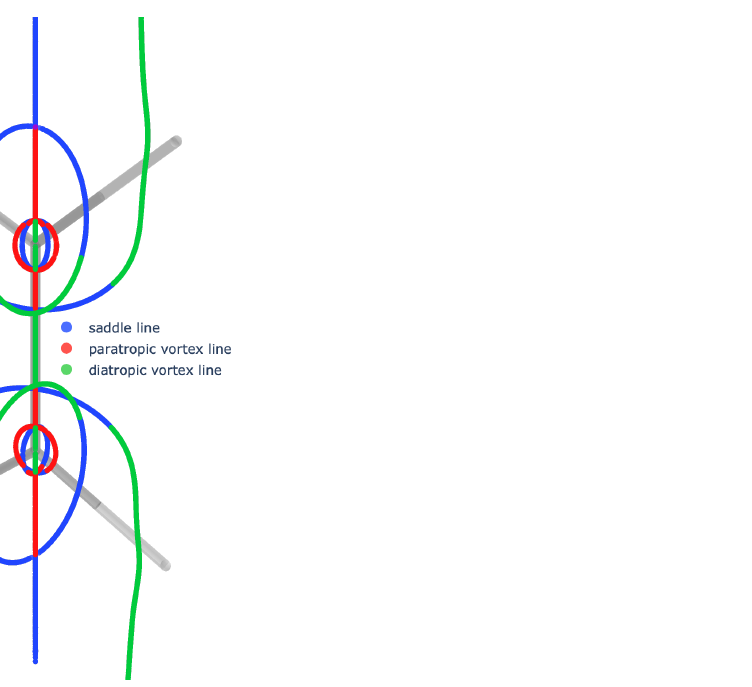
Figure 7. The stagnation graph of the C 2 H 4 molecule in its equilibrium geometry with a magnetic field of 0.05 B 0 along the z -axis. The interactive version of this figure may be found in C2H4_B005.html of the Supporting